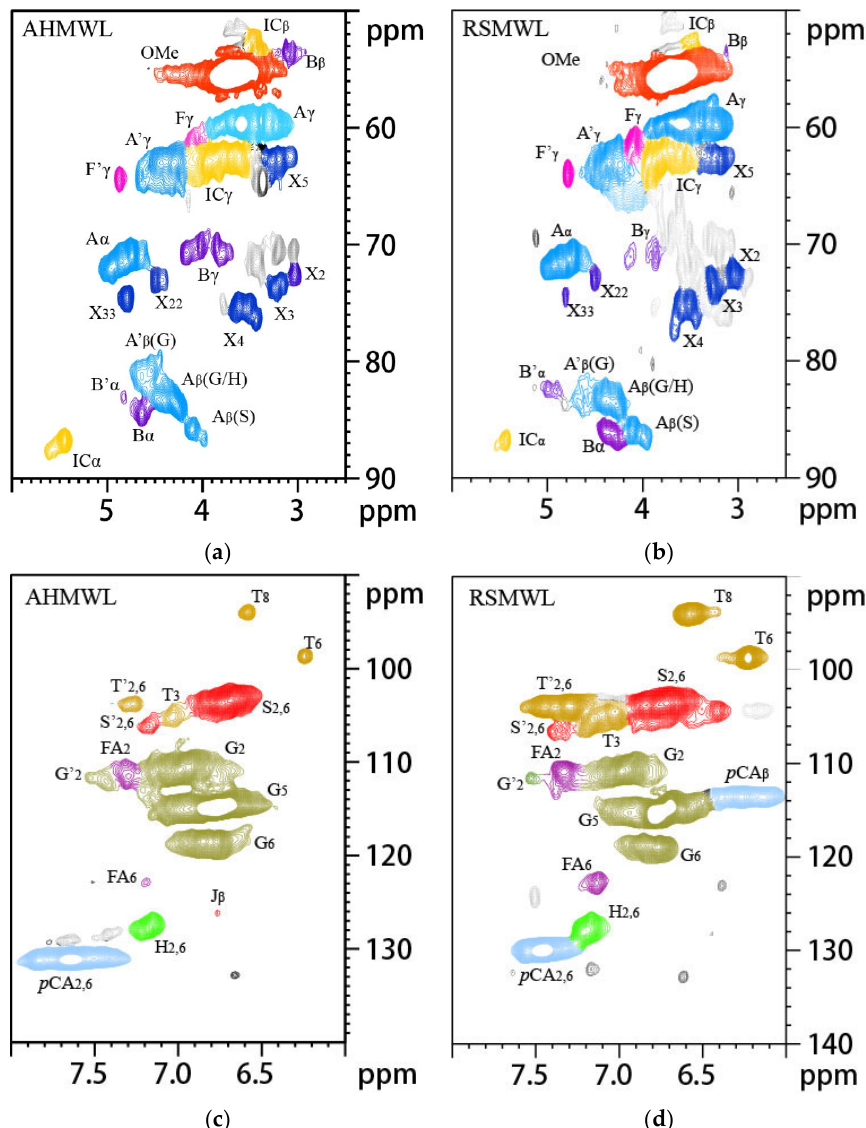
Figure 5. The 2D-HSQC NMR spectra of AHMWL and RSMWL: ( a ) The spectra of the AHMWL side-chain region; ( b ) The spectra of the RSMWL side-chain region; ( c ) The spectra of the AHMWL aromatic region; ( d ) The spectra of the RSMWL aromatic region.